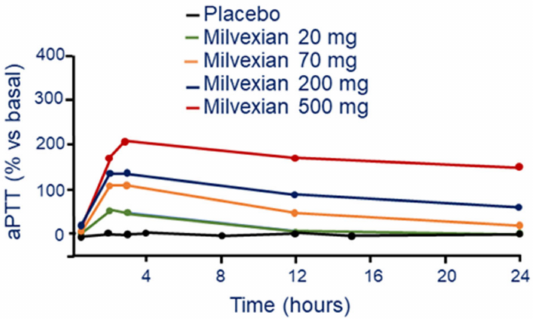
Figure 6. Dose and time-dependent effect of milvexian on aPTT following a single oral tablet administration. Modified from Perera, V et al. [33]. aPTT: activated partial thromboplastin